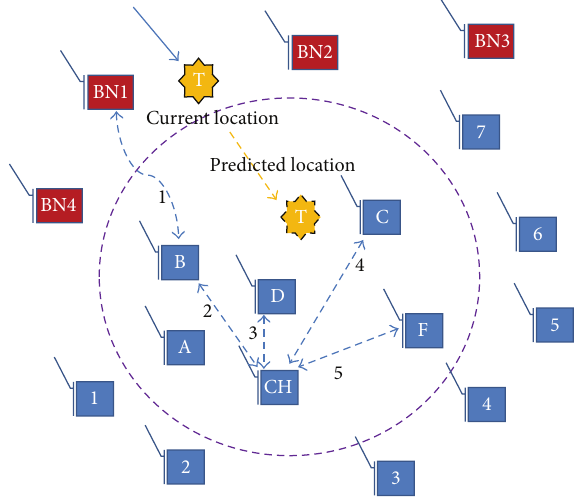
Figure 1: Static clustered